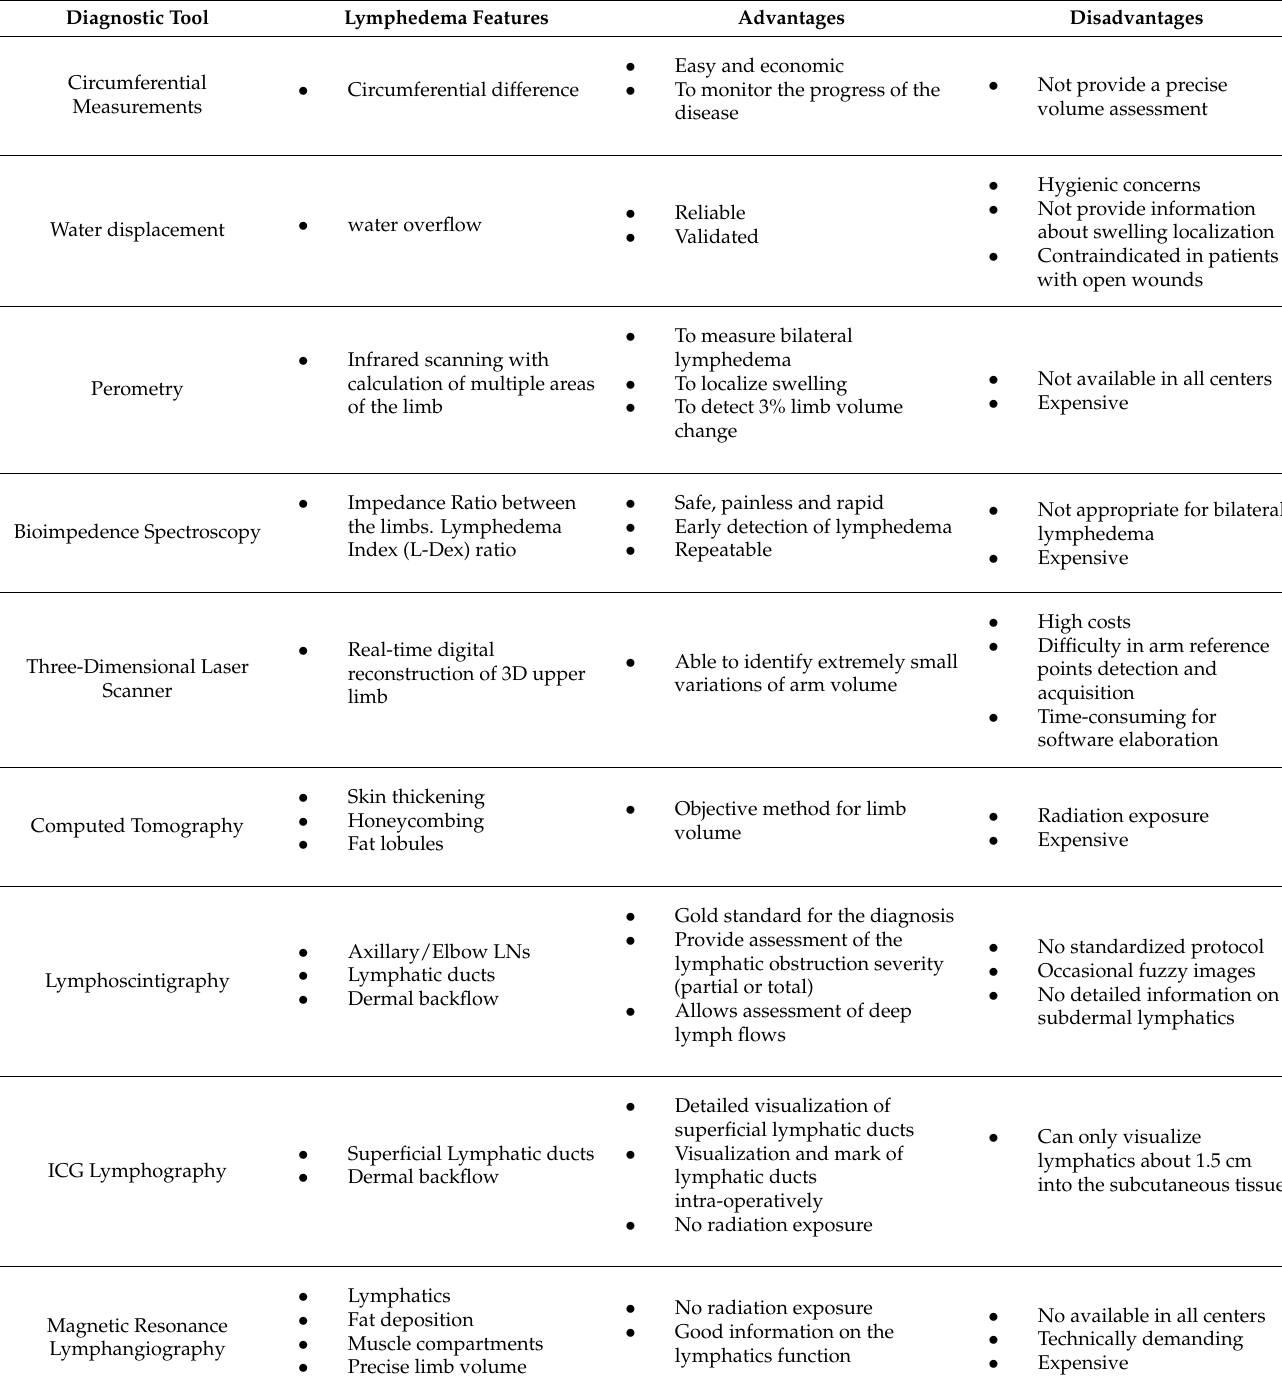
Table 1. Comparison between Different Diagnostic Tools for the Diagnosis of Breast Cancer-related Lymphedema. Diagnostic